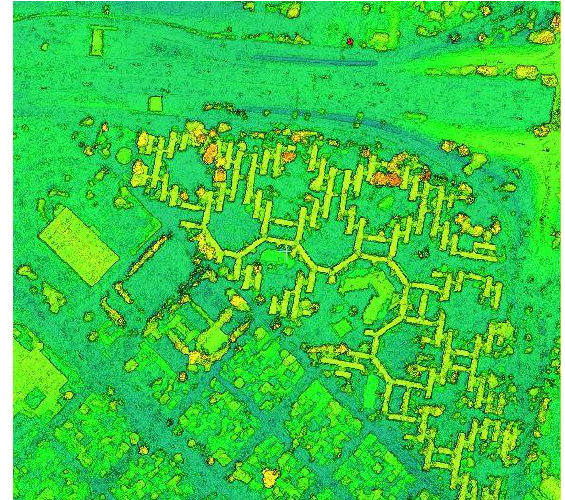
Figure 10. The 3D model of the fused point cloud